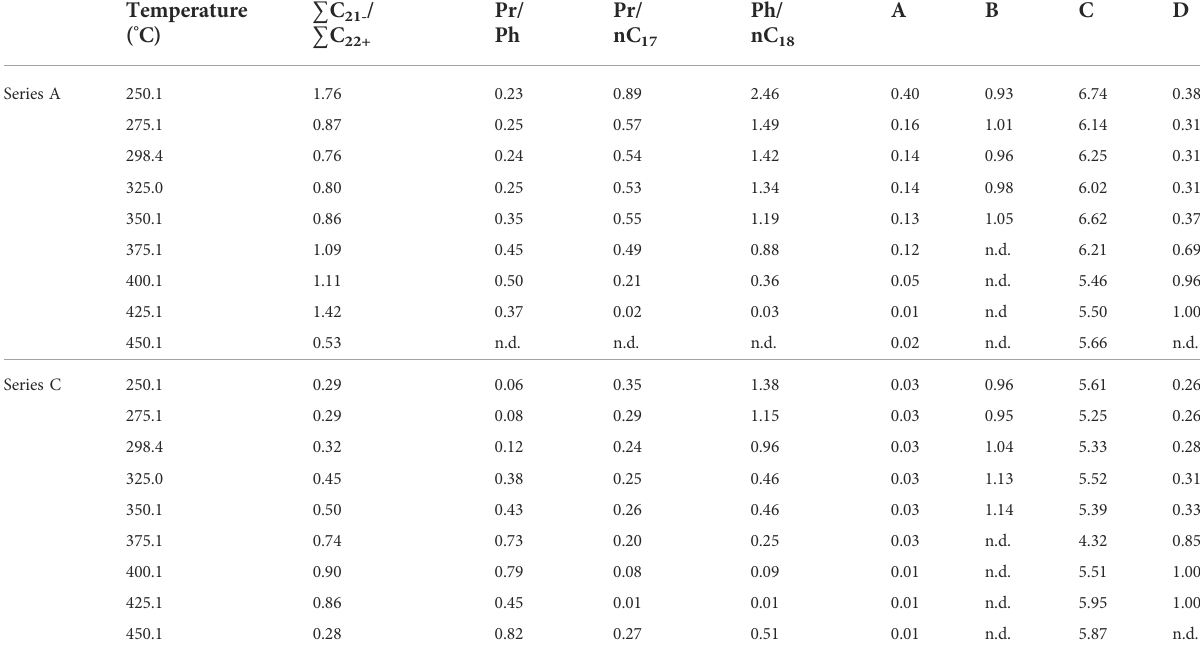
TABLE 4 Characteristics of biomarkers in experimental series A and C.